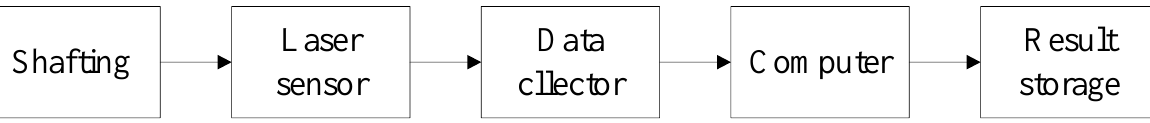
Figure 5. Schematic diagram of the test system. Table 3. Parameters of the laser sensor.